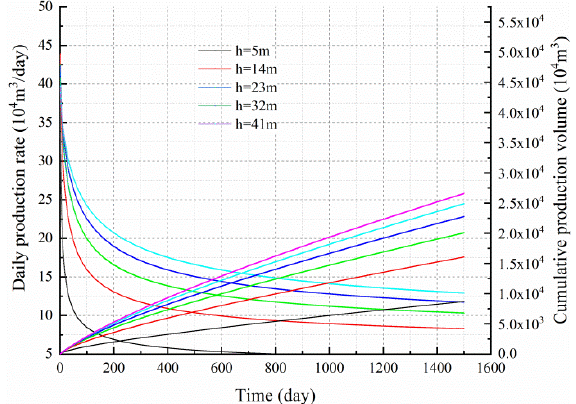
Figure 12. The e ff ect of di ff erent formation thicknesses on Figure 12. The effect of different formation thicknesses on productivity. Figure 12. The effect of different formation thicknesses on productivity.